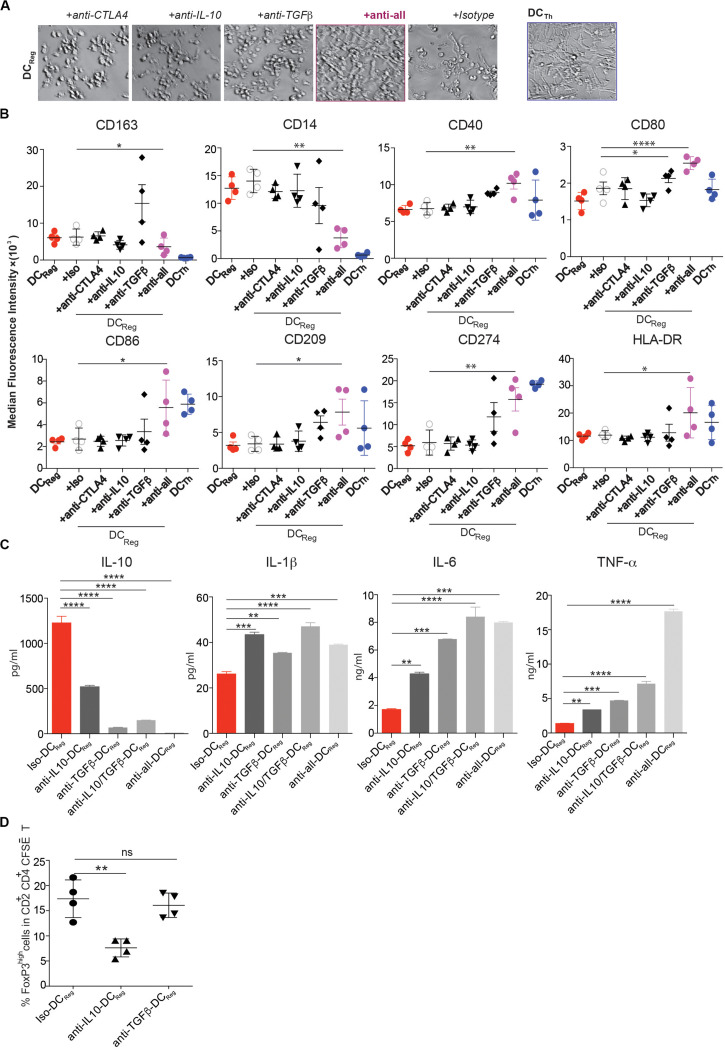
Blockade of CTLA-4, IL-10 and TGF-β prevents DCReg differentiation. (A–D) CD14+ monocytes were cultured for 4 days with Tregs or Th alone, or with Tregs and together at a 1:1 ratio in the presence of anti-CTLA-4 (5 μg/ml), anti-IL-10 (2 μg/ml), anti-TGFβ (2 μg/ml), or a mixture of these antibodies or isotype control antibody (5 μg/ml). (A) Images were captured with a bright-field DIC microscope on day 4. Original magnification 200×. (B) MFIs of DC-associated molecules on monocyte-derived cells are shown after excluding CD2+HLA-DR– T cells. (C) On day 4, moDCs (HLA-DR+CD2– cells) from the cultures in (A,B) were purified by FACS, and 200,000 cells were cultured in 200 μl containing 1 μg/ml LPS. After 16h, IL-10, IL-1β, IL-6 and TNFα levels in the cell-free supernatants were determined by Luminex. (D) On day 3, 1 μg/ml LPS was added to selected wells, and 16h later FACS-purified DC subsets were further cultured with MACS sorted CFSE-labeled naïve allogeneic CD4+ T cells. After another 6 days, CD2+CD4+ T cells were analyzed by flow cytometry. Mean ± SEM of 4 donors. *P < 0.05, **P < 0.01, ***P < 0.001, ****P < 0.0001, ns, not significant. Data were analyzed with one-way ANOVA, followed by Dunnett’s test for multiple comparisons.